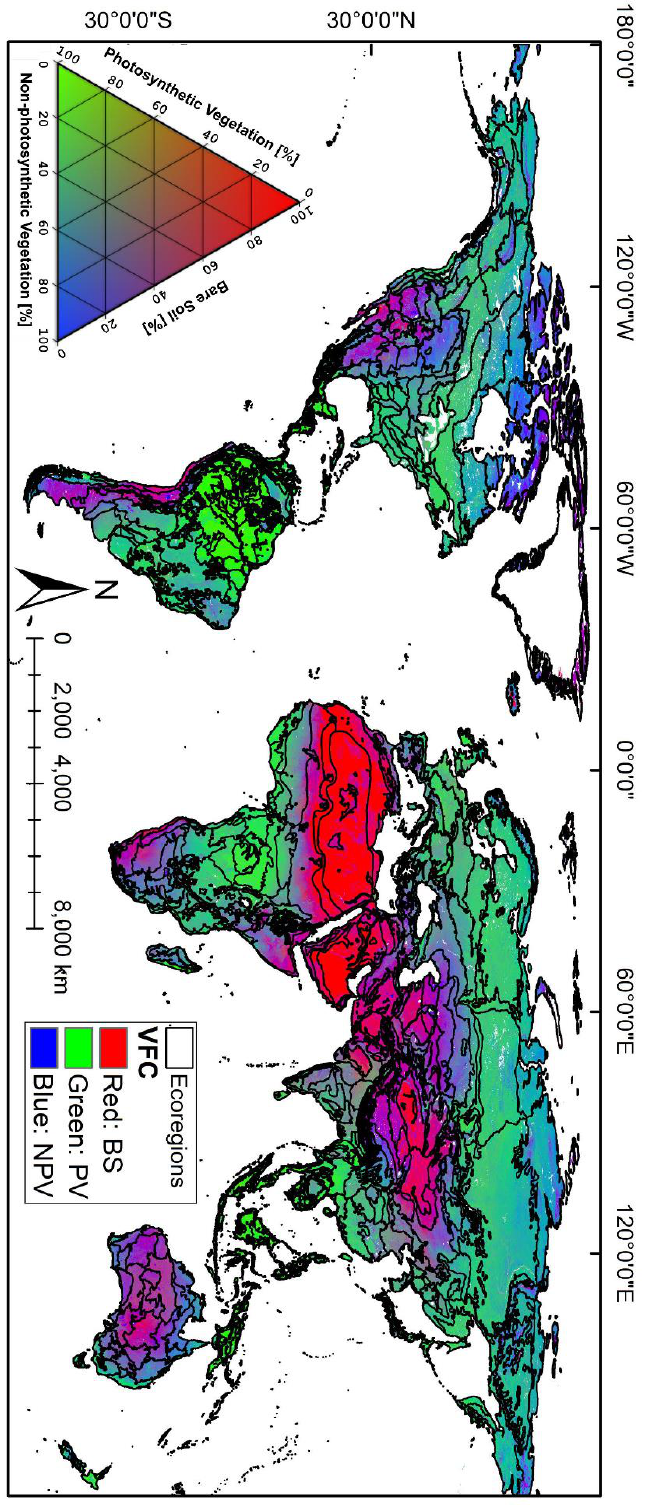
Figure 2. Global average fractional cover from 2001–2018. The ternary plot shows the correspondence between colour and the values fractions of photosynthetic vegetation ( F PV ), non-photosynthetic vegetation ( F NPV ) and bare soil ( F BS ). Each ternary axis represents colours corresponding to two-factor mixtures, the greater colour intensity indicates more dominance of a single cover type.